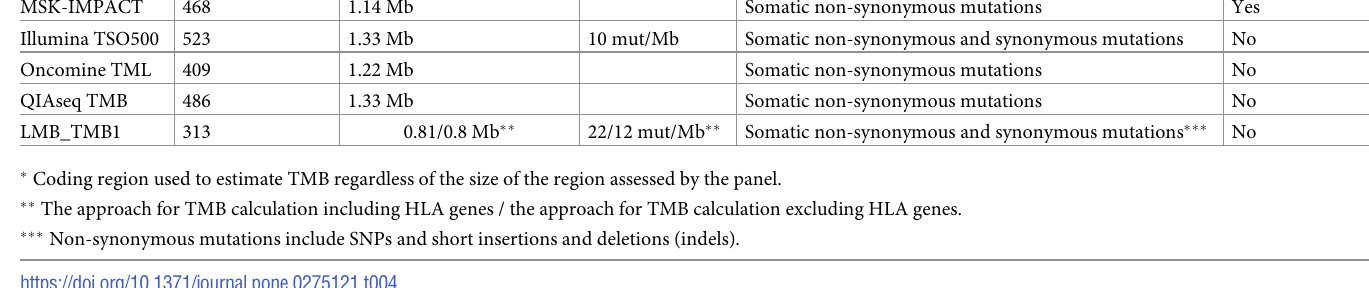
Table 4. Comparison of currently used gene panels for tTMB calculation [30, 31] with our panel (LMB_TMB1). Gene panel Number of genes Size region covered � (Mb) TMB cut-off